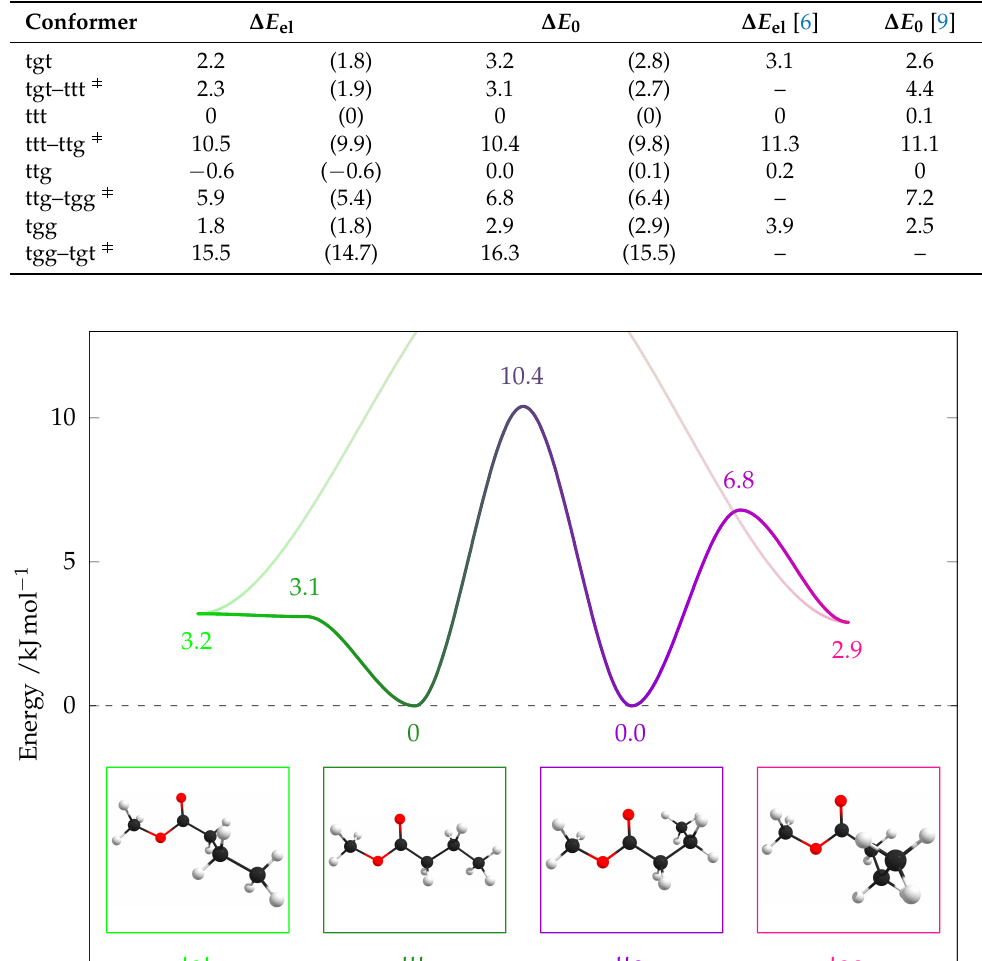
Table 4. Relative energies of minima and transition states ( ) of methyl butanoate in kJmol − 1 on CCSD(F12*)(T*)//B3LYP level, without ( ∆ E el ) and with B3LYP ZPE included ( ∆ E 0 ). In parentheses, the results without CCSD(T) correction are given. Reference values for ∆ E el on B3LYP/6-31G(d) level [6] and ∆ E 0 on B2PLYP-D3BJ/aug-cc-pVTZ level [9] added for comparison.